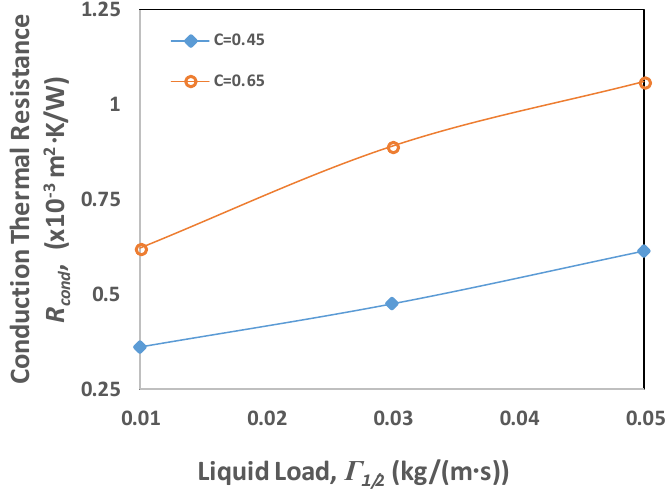
Figure 12. Average conduction thermal resistance variation w.r.t. liquid load.